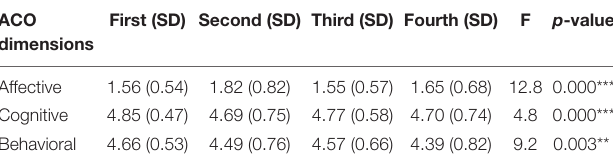
TABLE 3 | Items of the ACO scale adapted for nursing students according to the academic